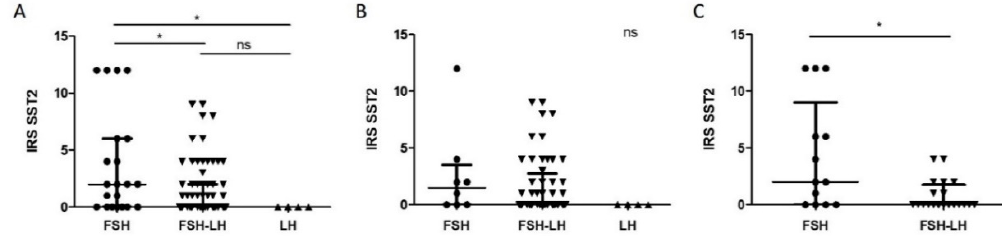
Figure 2. Tumor subtype-related comparison of IRS SST2 distribution in all ( A ), male ( B ) and female ( C ) cases. Graphs: median with interquartile range; each individual point represents a tumor: circles represent FSH tumors, down-pointing triangles FSH-LH tumors, and up-pointing triangles LH tumors. ( A ). Statistical test: Kruskal–Wallis, p = 0.01, n = 21, 72, 4, with Dunn’s test for columns comparison. ( B ). Statistical test: Kruskal–Wallis, p = 0.15, n = 8, 52, 4. ( C ). Statistical test: Mann–Whitney, p = 0.01, n = 13, 20. Abbreviations: immunoreactive score (IRS), somatostatin receptor 2 (SST2), follicle-stimulating hormone (FSH), luteinizing hormone (LH), not significant (ns), p < 0.05